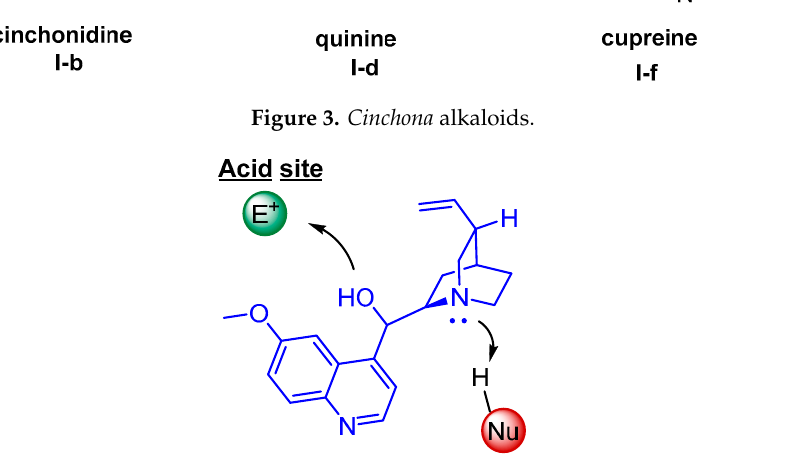
Figure 3. Cinchona alkaloids.